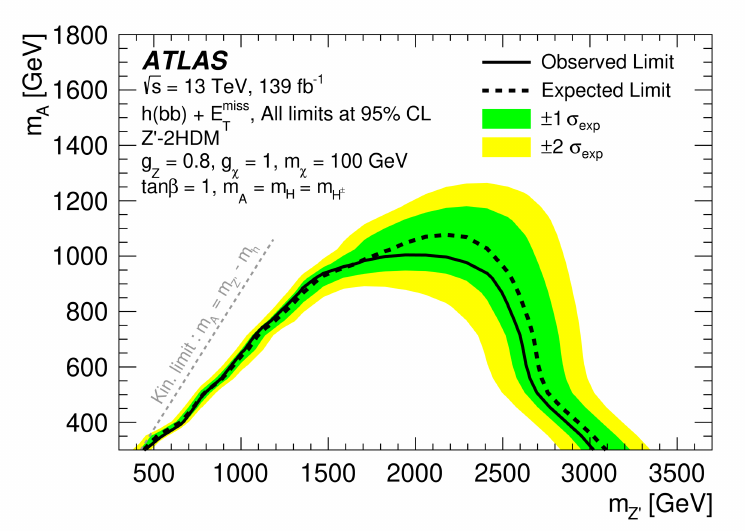
Figure 7. Exclusion limits in the Z 0 -2HDM model. The solid black line shows the observed limit at 95% CL, the dashed black line the expected limit. The green band gives the ± 1 σ uncertainties of the expected limit, the yellow band the ± 2 σ